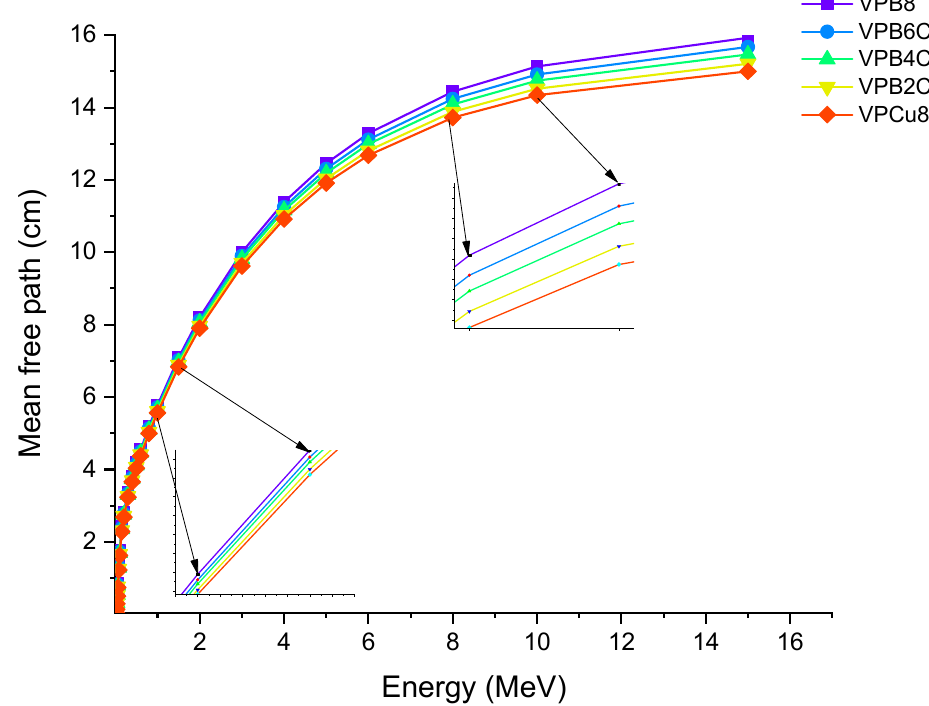
Figure 9. Variation of mean free path ( λ ) against photon energy for VPB x Cu y glass samples. Figure 10 depicts the change in effective atomic number (Z eff ) values as a function of photon energy. In general, higher-atomic-number elements are thought to have better gamma ray attenuation. Furthermore, materials having a higher fraction of elements with higher Z values absorb gamma rays more effectively. The obtained results showed that VPCu8 has the highest Zeff value. The maximum difference in Z eff values was seen at 0.04 MeV as 17.43,17.73,18.03,18.31, and 18.58 for glass samples VPB8, VPB6Cu2, VPB4Cu4, VPB2Cu6 and VPCu8, respectively, in the region where photoelectric interactions are predominant. In our study, it was observed that as the % of CuO increases, Z eff values increase